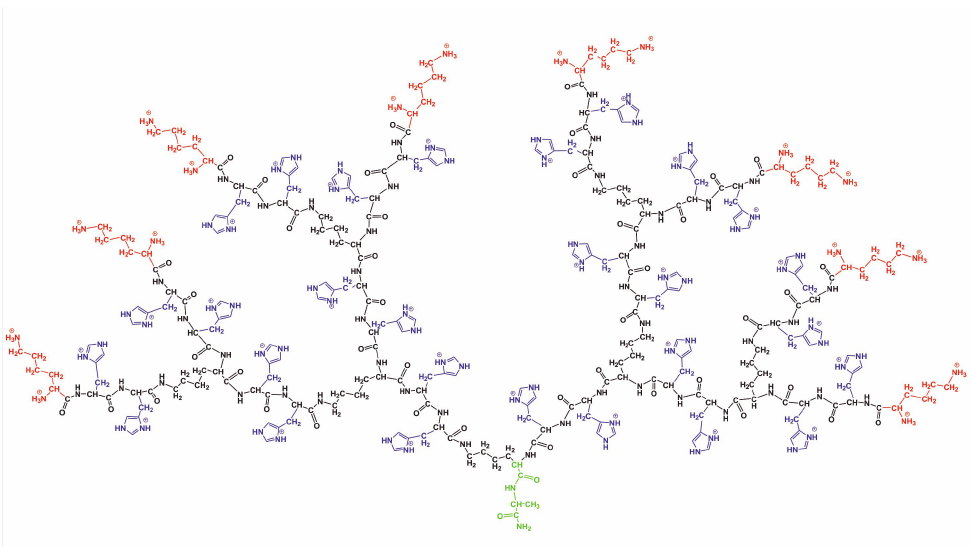
Figure 1. The chemical structure of the Lys-2Hisp dendrimer at low pH conditions. The dendrimer core is marked by green color, the backbone by black color, side segments by violet color and terminal lysines by red color. Table 1. The characteristics of the Lys-2His and Lys-2Hisp dendrimers: the molecular mass of dendrimer M and its charge Q bare , number N end and charge Q end of end groups, as well as number N ins and charge Q ins of inserted histidine amino acid residues and total number N H molecules in systems, and the average size a cell of the simulation